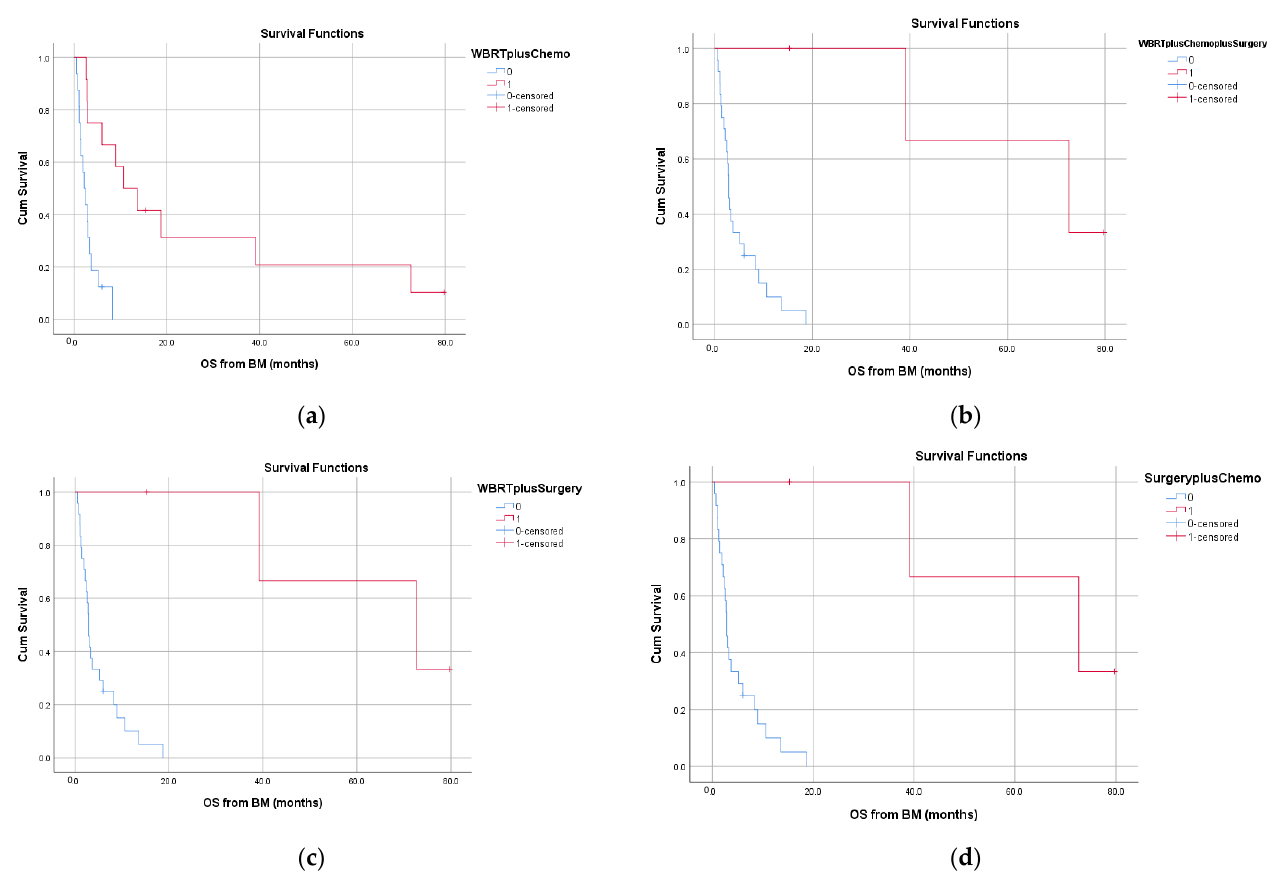
Figure 4. Overall survival (OS) from brain metastases according to combination therapy with ( a ) whole-brain radiation therapy (WBRT) + chemotherapy, ( b ) WBRT + chemotherapy + surgery, ( c ) WBRT + surgery and ( d ) surgery + chemotherapy.